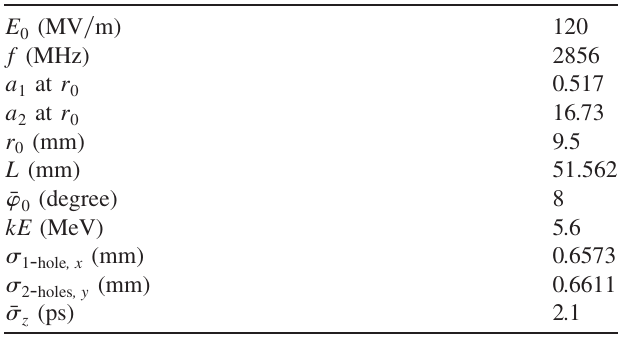
TABLE III. Parameters used in numerical calculation of the beam offset and the emittance growth.